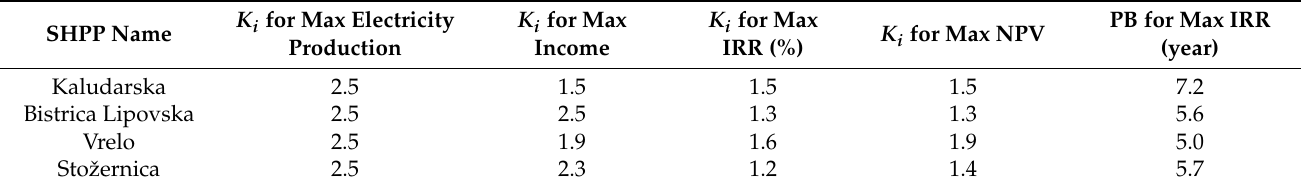
( b ) Figure 6. ( a ) Annual electricity production and income—Bistrica Lipovska SHPP; ( b ) NPV, IRR, and PB—Bistrica Lipovska SHPP.